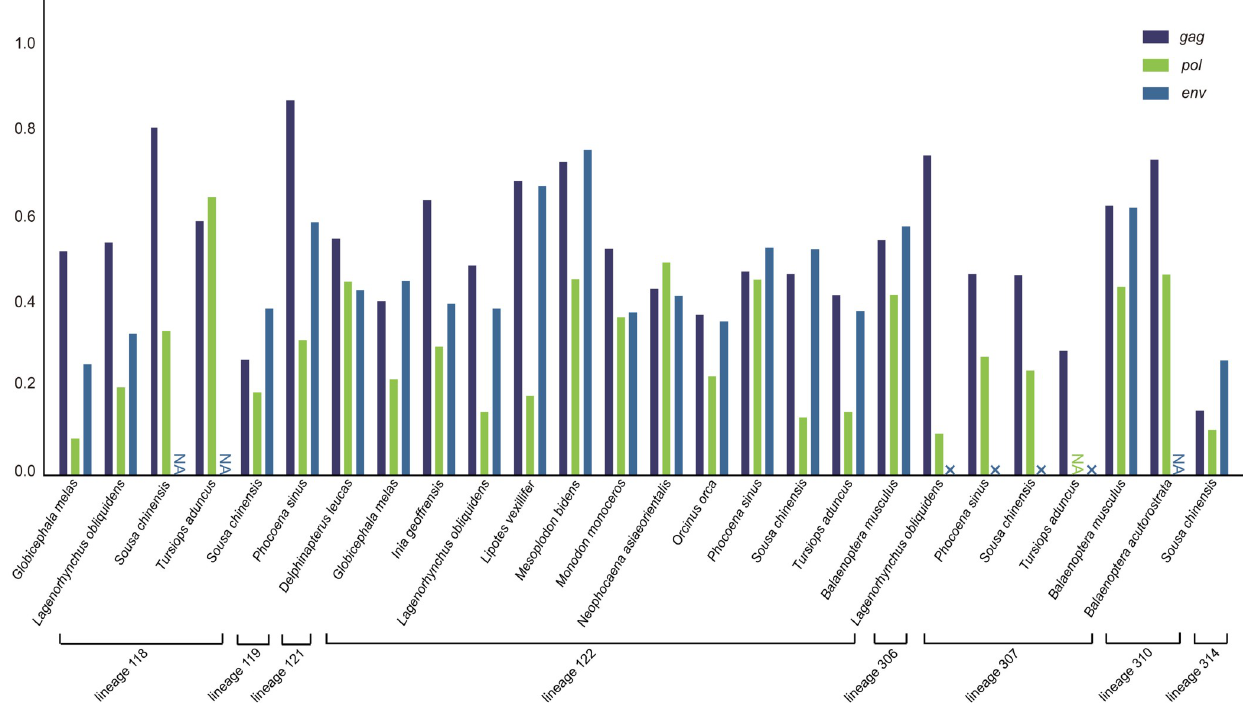
Fig 6. Selection pressure on the genes of cetacean ERVs. The dN/dS ratio values of three retroviral genes ( gag , pol , and env ) of the SHS ERV lineages in a certain species are shown. NA indicates not applicable, because information is not enough for the dN/dS calculation. × represents the loss of the corresponding